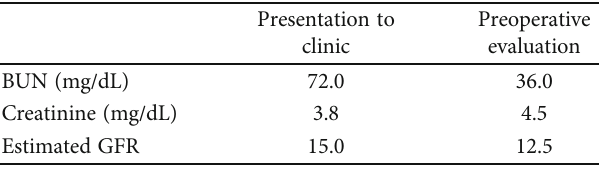
Figure 1: (a) MR Urogram showing the coronal view of the lesion measuring 0.29mm. (b) MR Urogram showing the axial view of the lesion measuring 31 : 2 mm × 40 : 0 mm . Table 1: Baseline renal function upon presentation to the clinic and renal function at the time of preoperative evaluation.